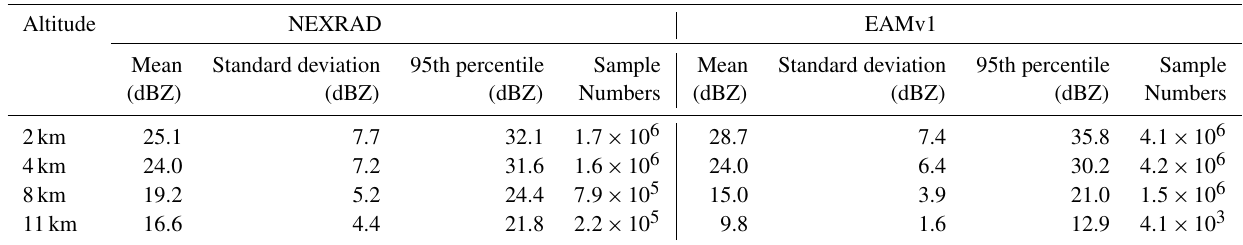
Table 2. The statistical comparison of radar reflectivity between NEXRAD and EAMv1.